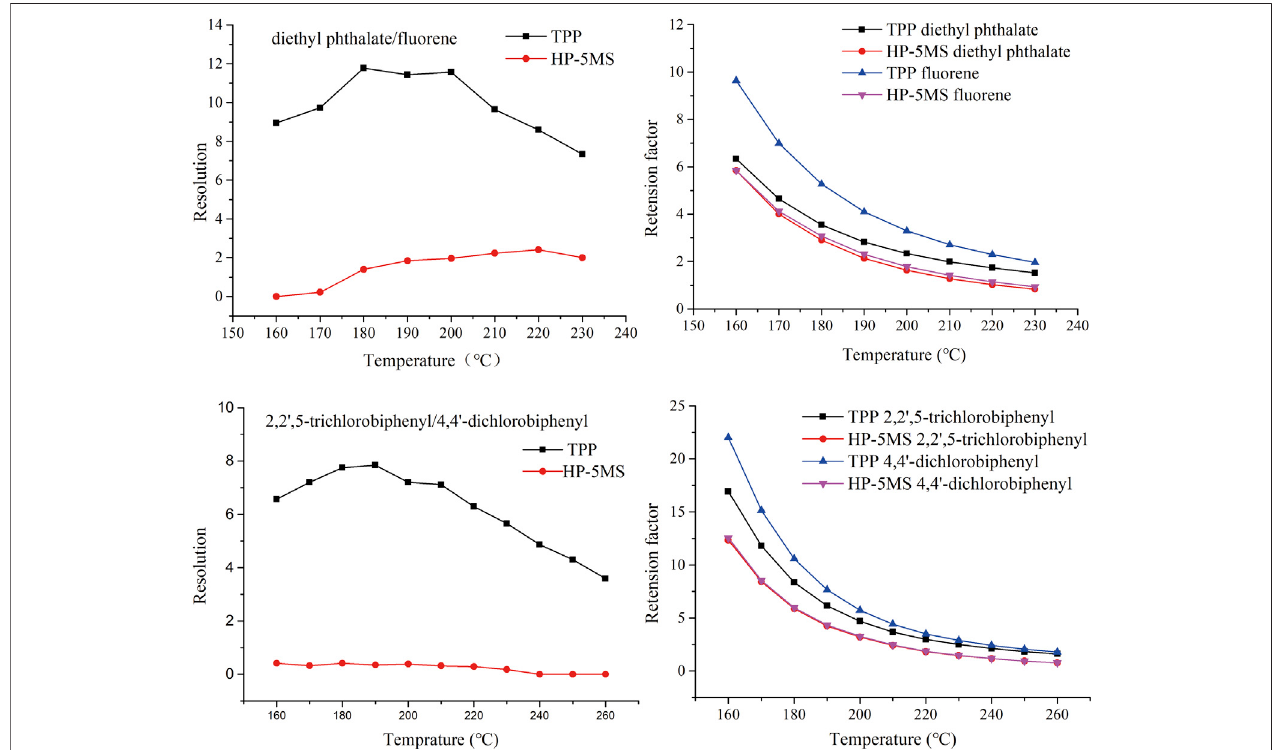
FIGURE 11 | Effect of column temperature on resolution and retention factor of diethyl phthalate and fl uorene (peaks 3 and 5) and of 2,2 ʹ ,5-trichlorobiphenyl and 4,4 ʹ -dichlorobiphenyl (peaks 6 and 7) on TPP and commercial capillary columns.